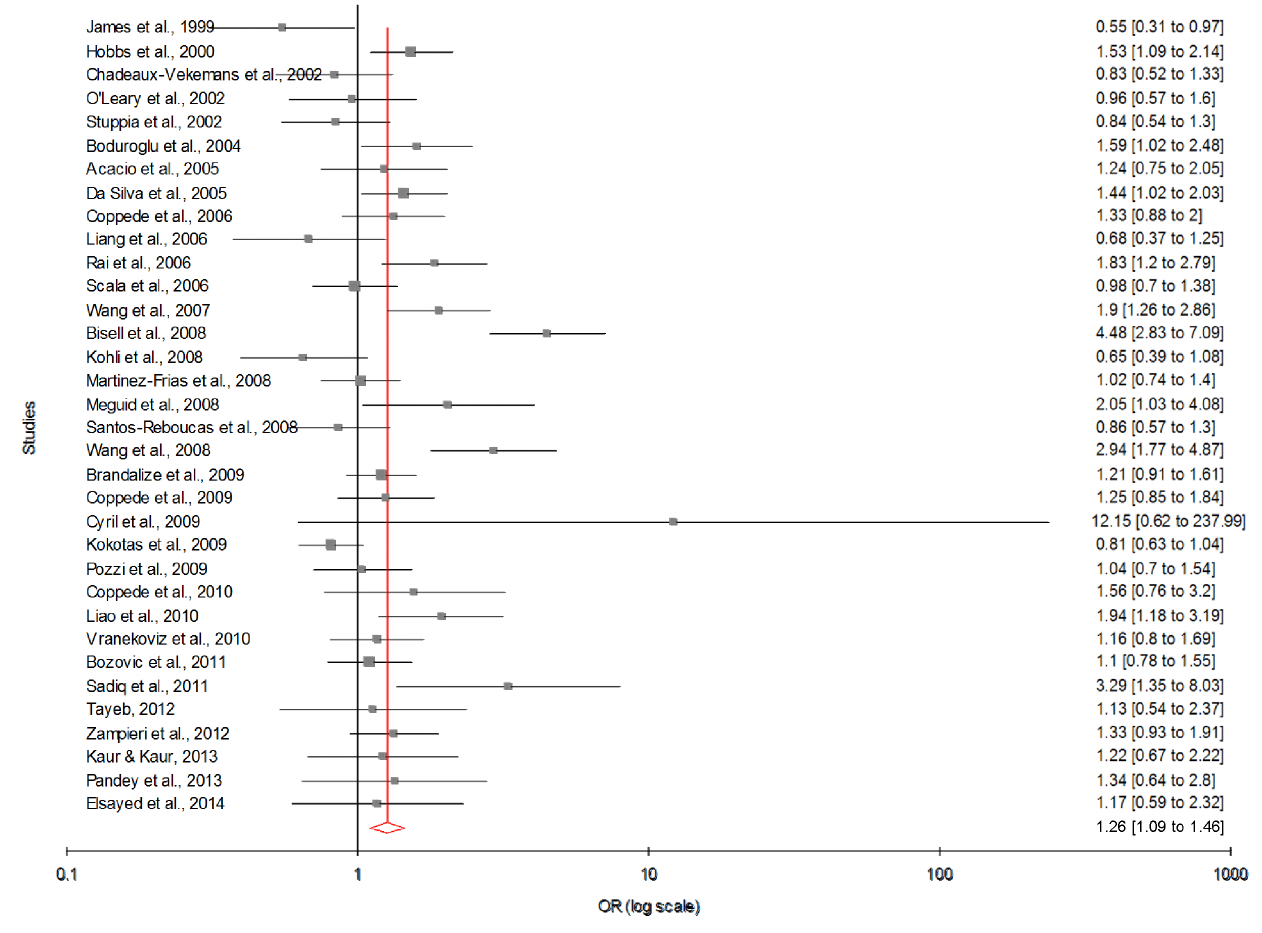
Figure 2. Forest plots (Random effect) showed significant association between MTHFR C677T polymorphism and risk of Down syndrome using allele contrast model (C versus T). Results of individual and summary OR estimates and 95% CI of each study were shown. Horizontal lines represented 95% CI, and dotted vertical lines represent the value of the summary OR.